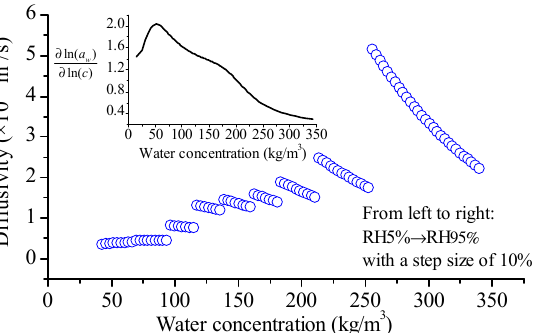
Figure 6. Variation of water diffusivity in glutinous rice grains with water concentration during the adsorption with an RH step size of 10%. Here, the diffusivities were obtained according to Fick’s second law with potential chemical gradient as a driving force for water di ff usion.